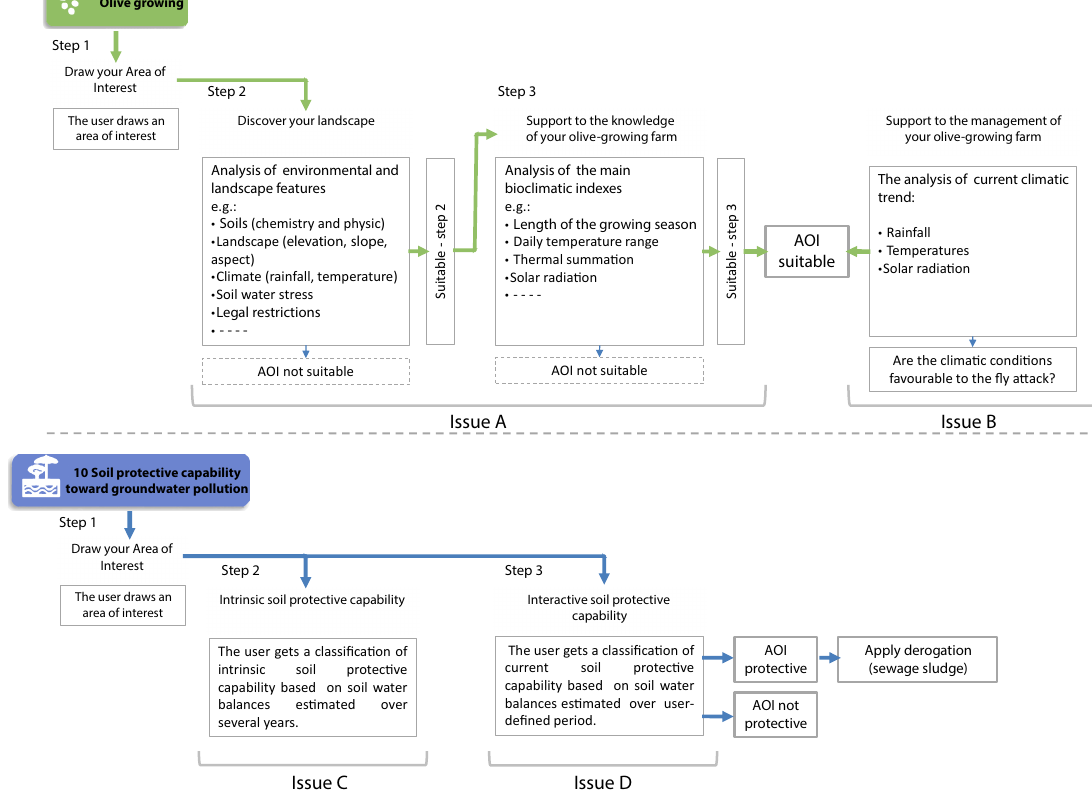
Figure 5. Flow diagram illustrating the steps to be undertaken for addressing issues